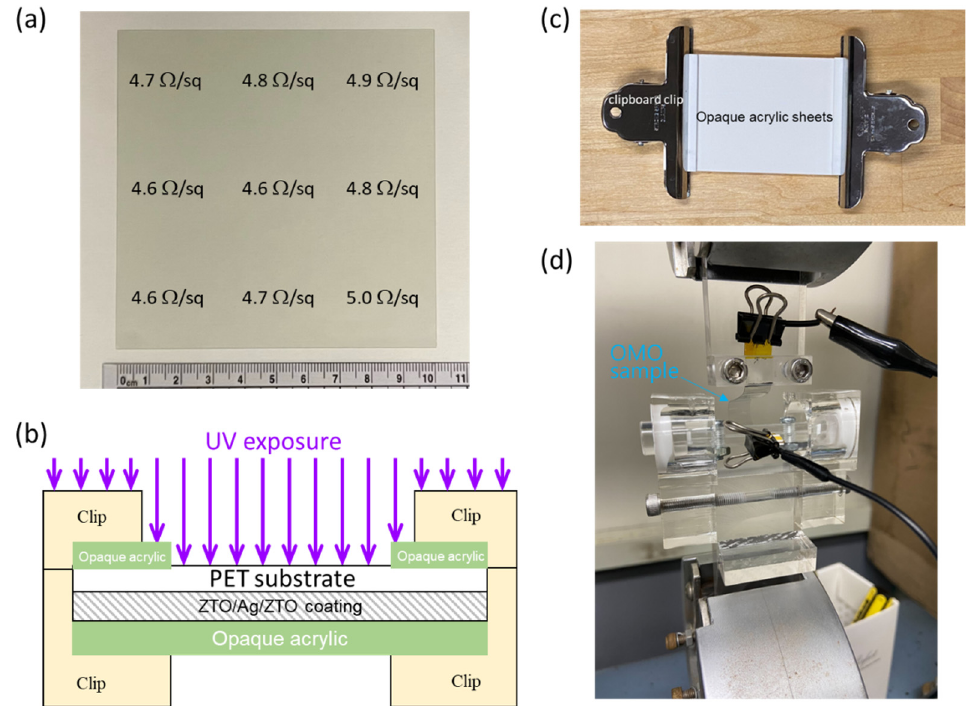
Figure 1. ( a ) A photo of the OMO sample with the corresponding measured sheet resistance values. ( b ) The experimental setup of the weathering tests. ( c ) A photo of the sample holder for the weathering tests. ( d ) Real-time resistance measurement under cyclic bending.